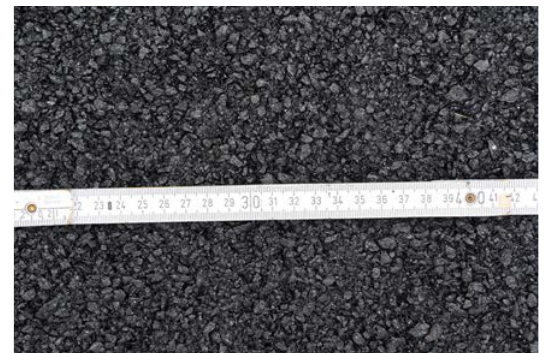
Figure 11. Paving of the poroelastic mixture.